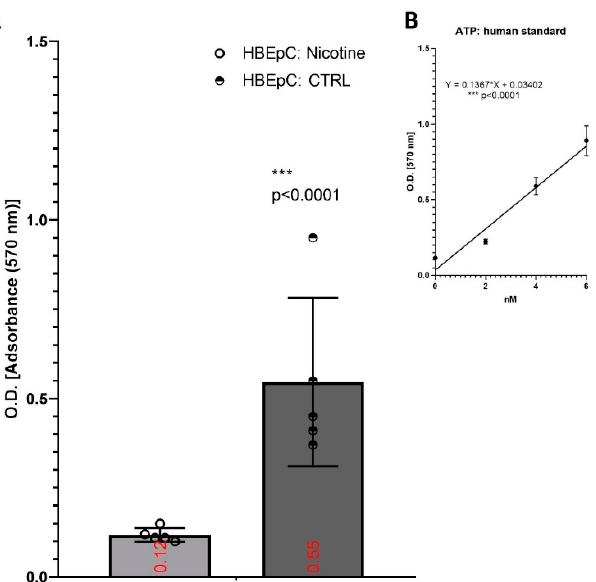
Figure 5. Evaluation of intracellular ATP after exposure to nicotine for 48 h in HBEpC. ( A ): ELISA experiments; ( B ): regression equation linearity, performed with Prism. Experiments are performed at least two times in triplicate.